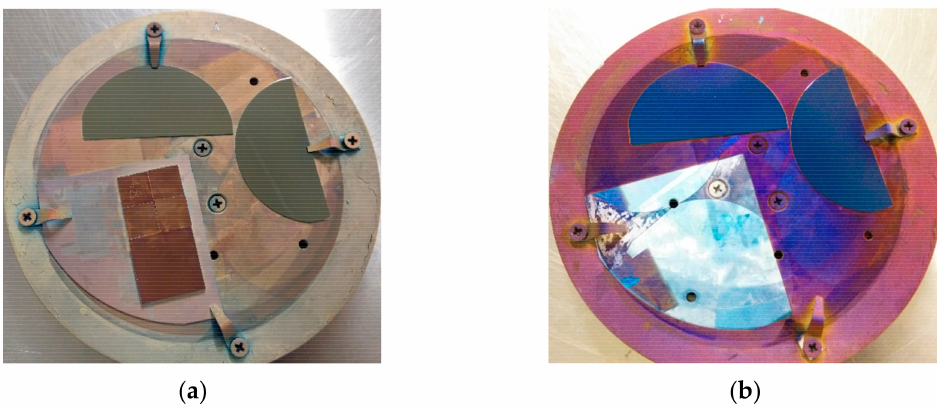
Figure 2. ( a ) the as-deposited thin film samples, ( b ) after AZO deposition.